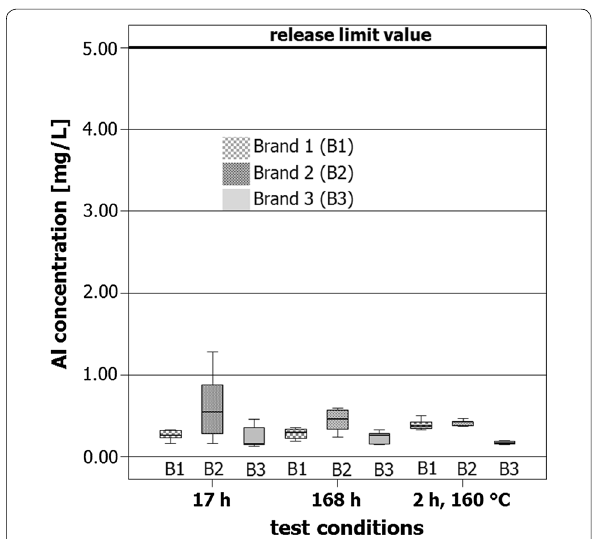
Fig. 4 Box plots of the aluminum concentrations in oil samples after migration from the different brands 1, 2, und 3 of pans under the vari‑ ous experimental conditions 17 h contact (17 h) at room tempera‑ ture, 168 h contact (168 h) at room temperature, and 2 h contact at 160 °C in the drying oven (2 h, 160 °C). The heavy line at 5.00 mg/L denotes the SRL